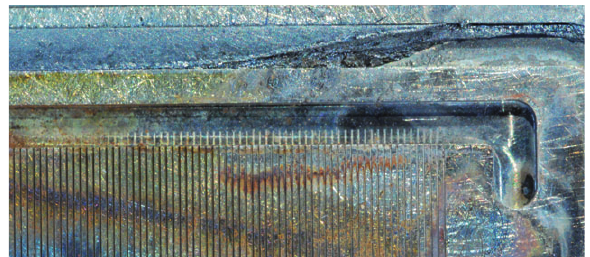
Figure 10 Magnified view of evaporation channels used. Micro- structures are intact and not blocked, while some removable flash rust can be seen on the